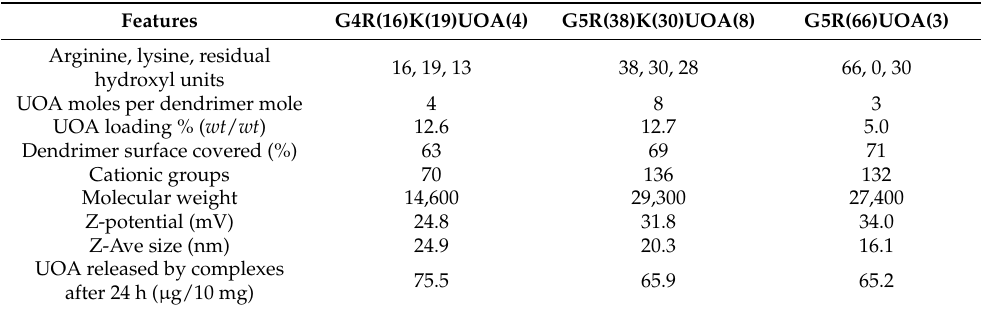
Table 2. Main structural characteristics and physicochemical properties of UOA-loaded cationic dendrimers prepared in this